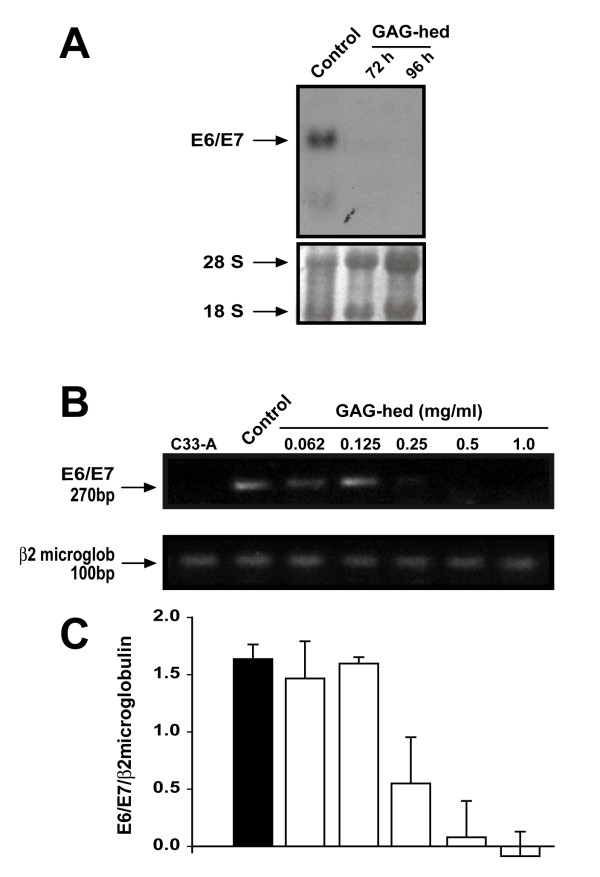
GAG-hed causes repression of HPV18 E6/E7 transcription in HeLa cells. (A) Northern blot was performed with total RNA obtained from HeLa cells treated with 2 mg/ml of GAG-hed and harvested 72 or 96 h later. During treatment, cells were grown in media with 2% serum. Control cells were harvested after 72 h. Gel image showing similar RNA loading in gel was taken before transfer and shown as reference. (B) Cells were treated with the indicated increasing concentrations of GAG-hed and total RNA was extracted after 48 h. RT-PCR assays were performed and DNA products were separated on agarose gels. RNA used as negative control was from C33-A cell line. E6/E7 transcript is denoted as a 270 bp band (top); same mRNAs were used to test the expression of β2-microglobulin, denoted as a 100 bp band (bottom). (C) Plot represents densitometryc data normalized against microglobulin optical density.